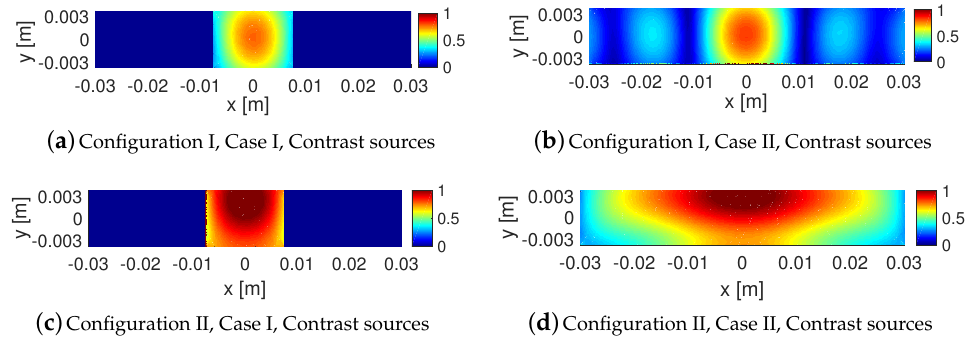
Figure 15. Induced contrast sources (their magnitudes) for Cases I and II for both configurations: using the Bessel beam launcher (Configuration I), and using the dipole antenna (Configuration II). The contrast sources in each configuration have been normalized with respect to the maximum of the incident field at that configuration.